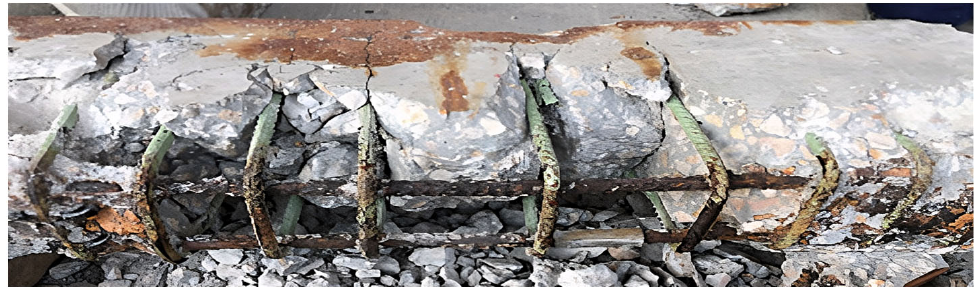
Figure 6. Extraction of the corroded bars from the beam.